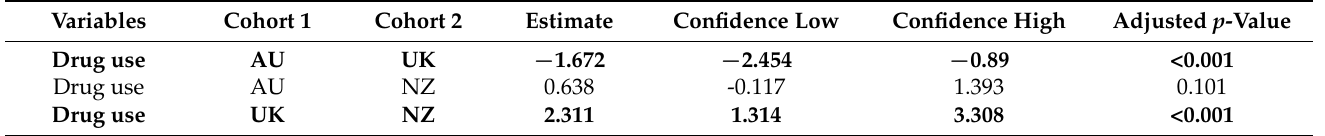
Table 7. High-risk profile post-hoc games Howell pairwise